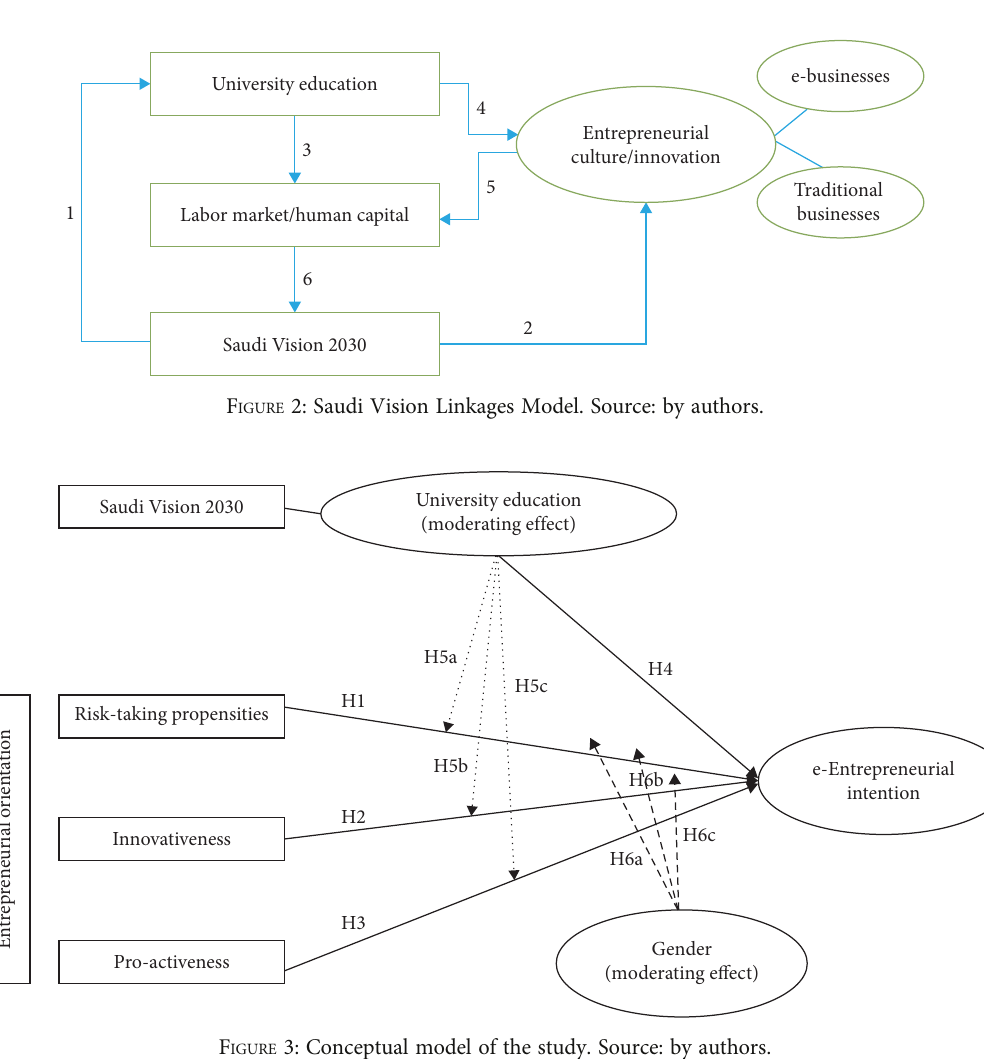
F IGURE 3: Conceptual model of the study. Source: by authors.